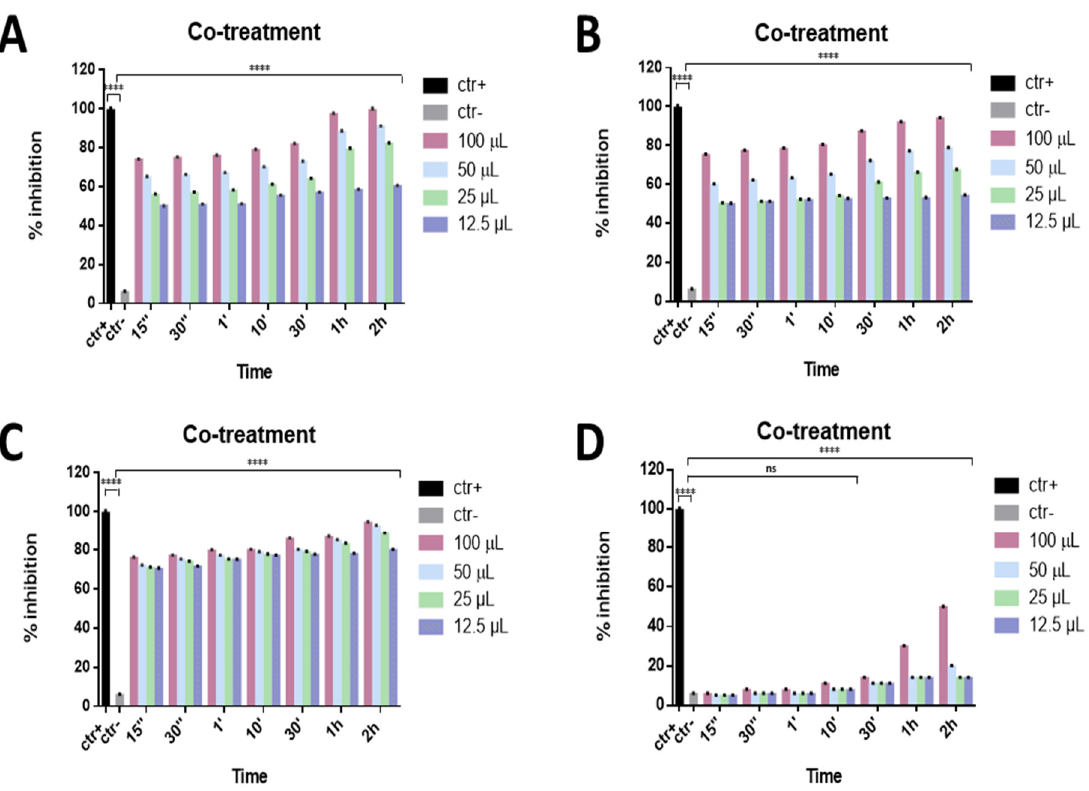
Figure 2. Co-treatment assay. Antiviral activity against SARS-CoV-2 of eye drops at different times of stimulation. Iodim ( A ), Ozodrop ( B ), Dropsept ( C ), and Septavis ( D ) were incubated simultaneously with SARS-CoV-2 on the cell culture for the several time points. Iodim, Ozodrop, and Dropsept inhibited the early stages of infection. On the contrary, Septavis was not able to block the viral replication. **** p < 0.0001; ns: non-significant.